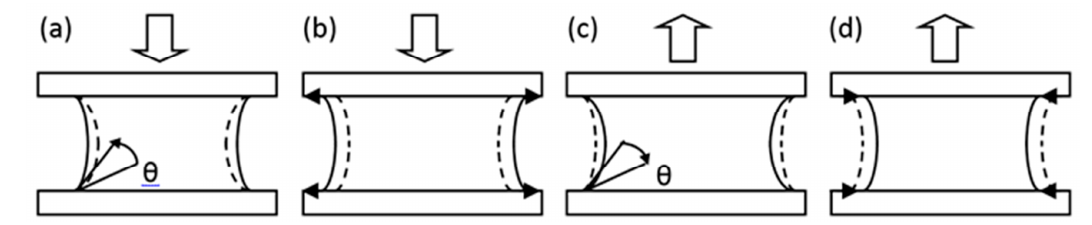
Figure 5. Schematic of the four stages of contact line motion during contact angle hysteresis.